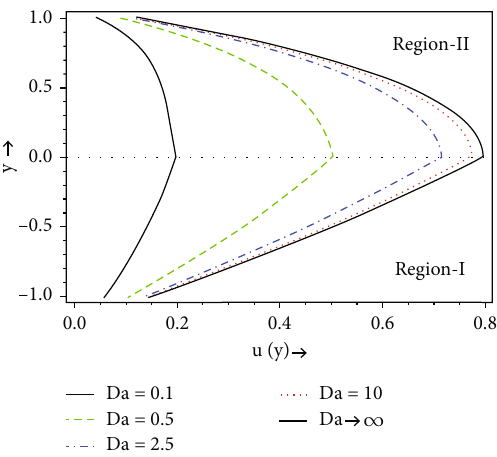
Figure 6: E ff ect of Darcy number Da = k / h 2 on velocity components.